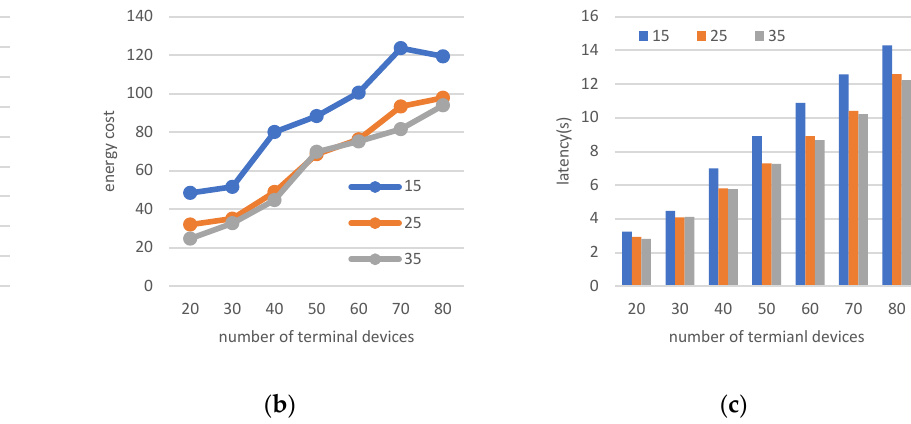
Figure 7. ( a ) Number of selected edge nodes; ( b ) energy cost; ( c ) latency when changing the number of edge nodes and terminals.